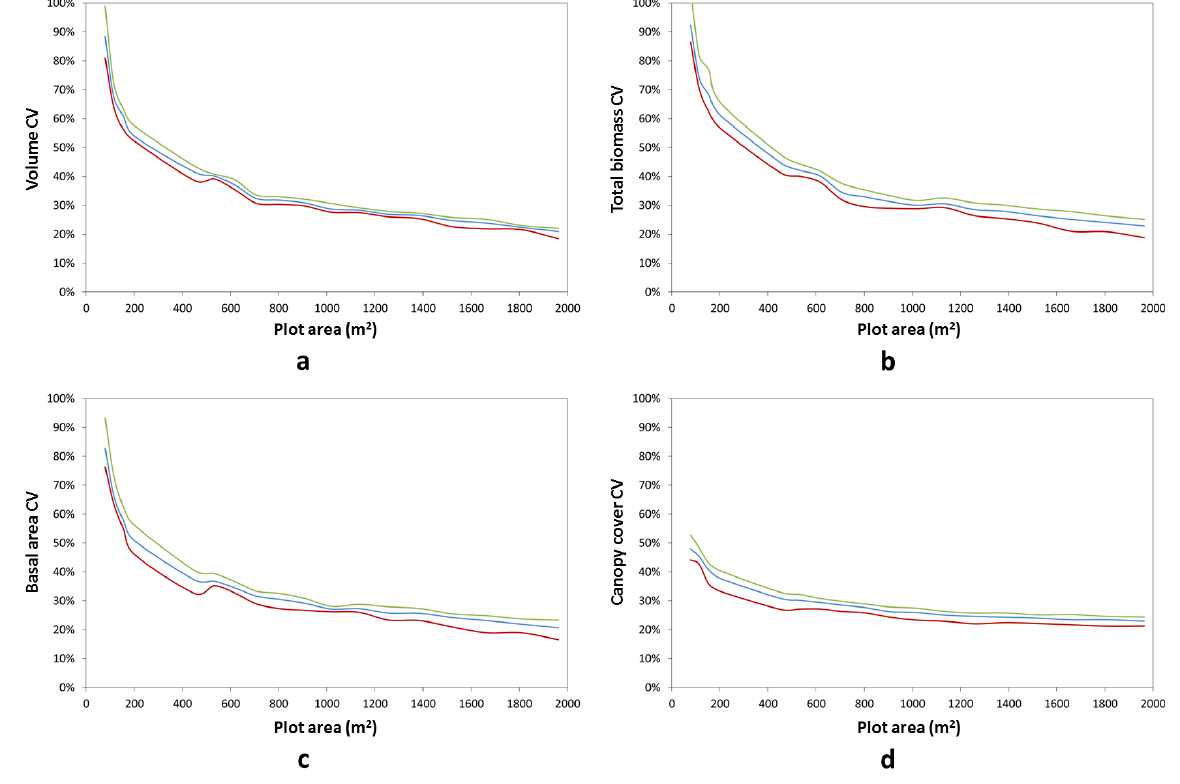
Figure 6. Evolution of mean (blue), maximum (green) and minimum (red) coefficient of variation (CV) values as plot size varies for forest stand variables: ( a ) volume; ( b ) total biomass ( c ) basal area, and ( d ) canopy